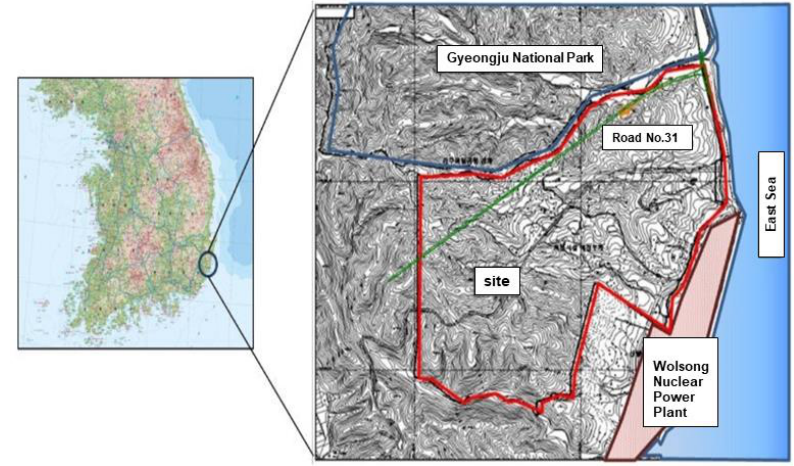
Figure 1. Location of the WLDC site in Korea.